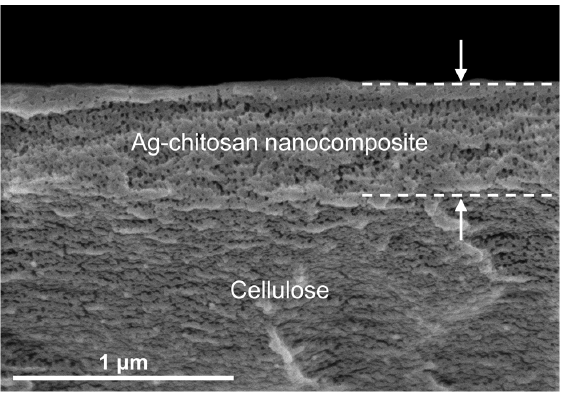
Figure 4. Cross-sectional view of Ag–chitosan nanocomposite on the cellulose substrate (thickness of Ag–chitosan nanocomposite, approx. 575 nm; diameter of nanopores, up to 30